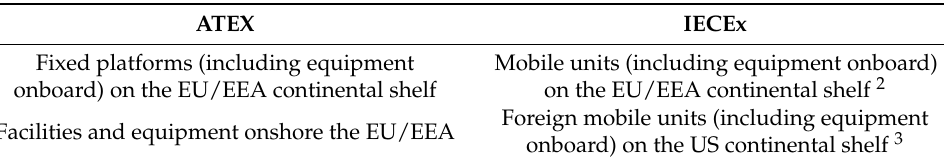
Table 1. Protection scheme against explosion on the US and the EU/EEA continental shelf 1.